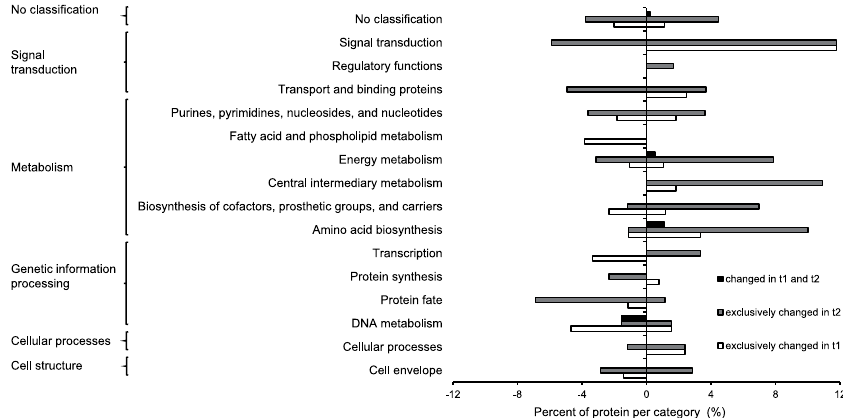
Figure 4. Impact of fungal volatiles on S. plymuthica PRI-2C protein content. The percentage of proteins with at least 1.5 fold change in relation to the number of identified proteins is depicted. Black bars indicate proteins with changed amount in both, early (t1, 48 h) and late (t2, 72 h) sampling points, grey bars indicate changed amounts on late sampling point, white bars indicate changed amount in early sampling point. Functional annotation is based on